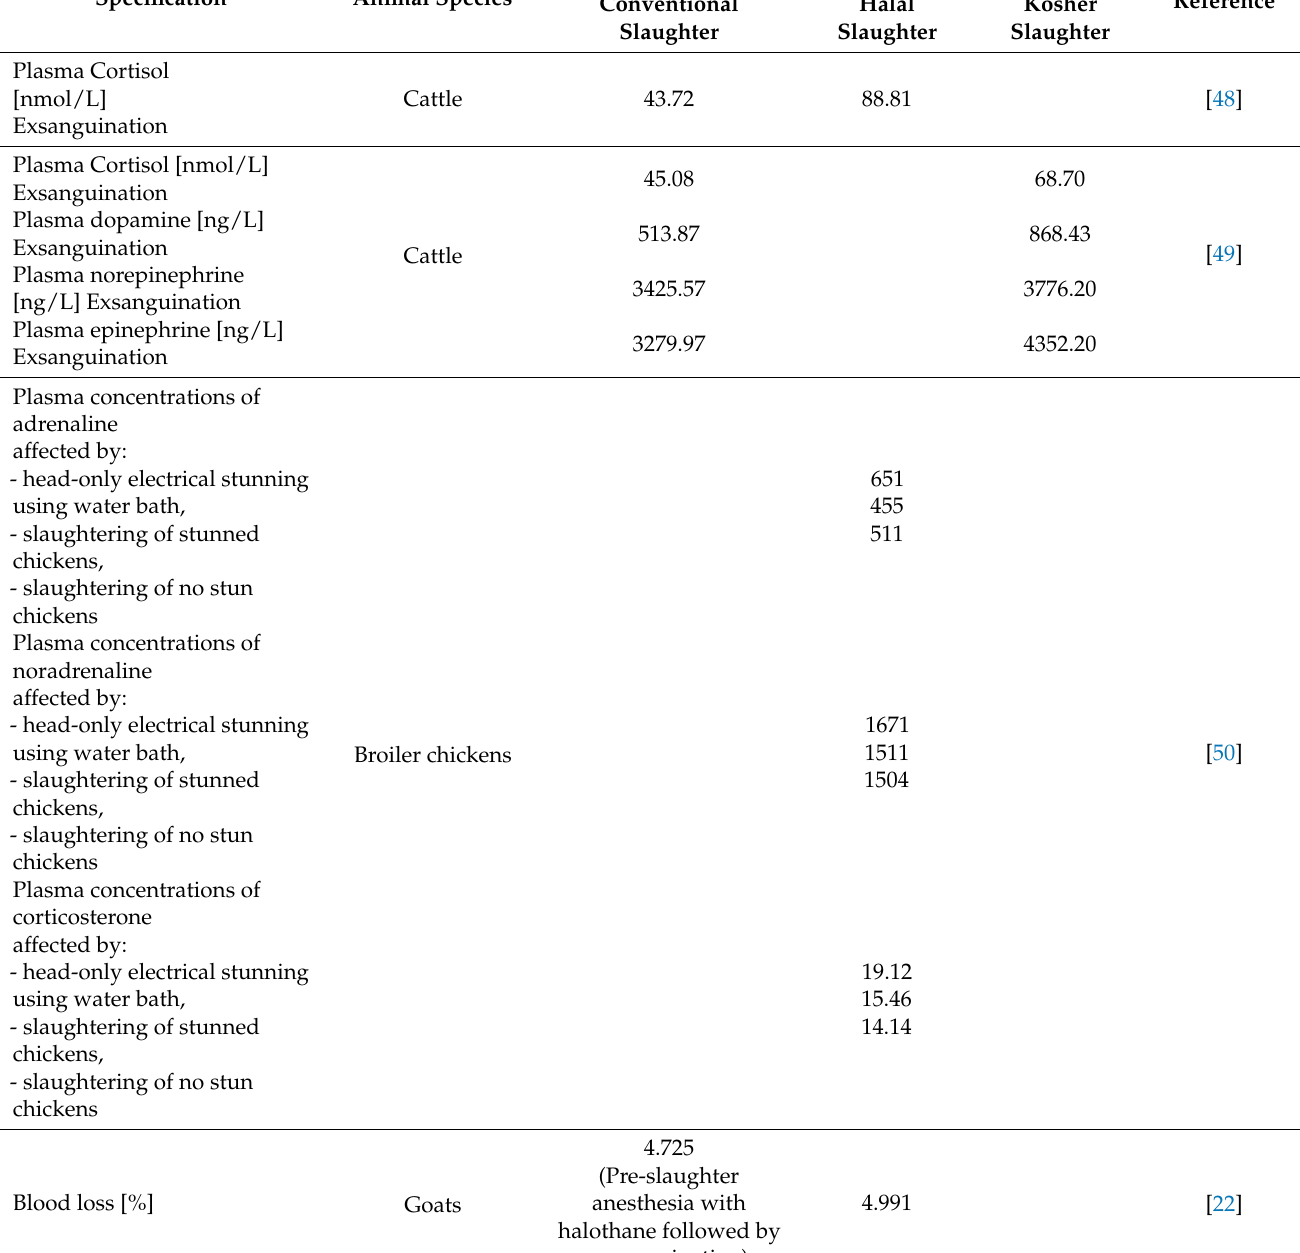
Table 1. Selected parameters of blood and meat of animals depending on the type of slaughter.